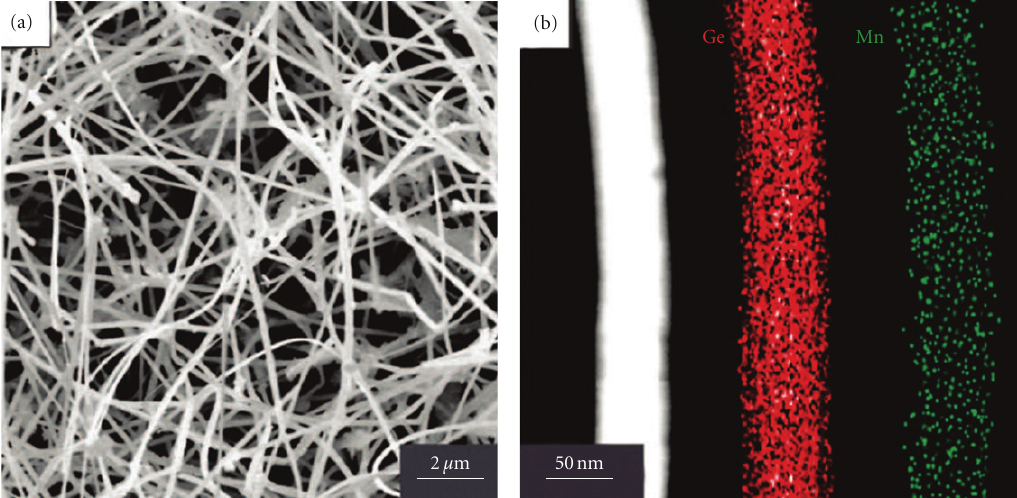
Figure 19: (a) SEM images of the Ge 0 . 8 Mn 0 . 2 NWs and (b) their STEM image and EDX elemental mapping, showing that 20% Mn element is distributed uniformly over the whole NWs. Reproduced from [22]. Copyright ©2008, American Chemical